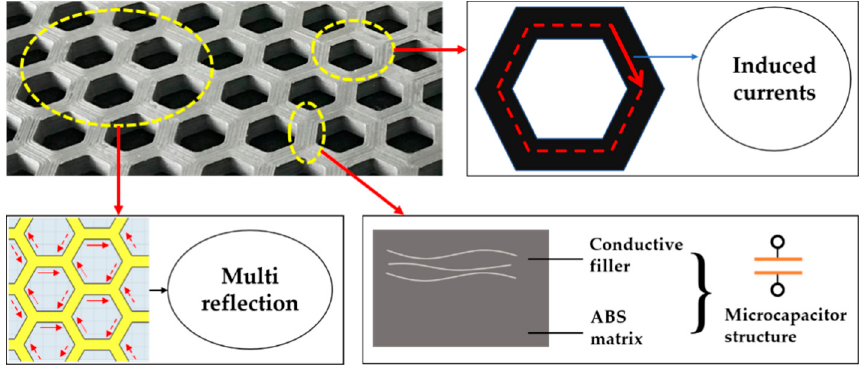
Figure 7. A hypothetical microscopic mechanism of the honeycomb-structural conductive ABS samples on electromagnetic wave (EMW) energy dissipation.